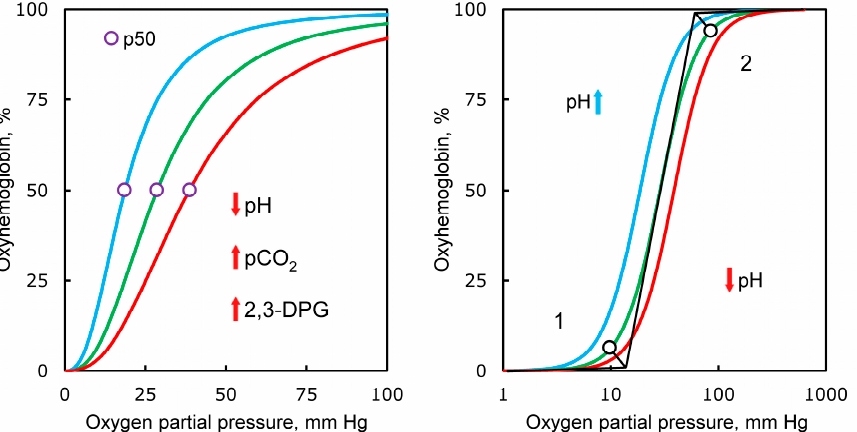
Figure 3. Different factors influencing oxygen saturation of hemoglobin. During pH change from 7.4 to 7.2, saturation decreases two times. The concentration of 2,3-diphosphoglycerate provides saturation of hemoglobin with oxygen, along with CO 2 pressure. pH, negative of the base 10 loga- rithm of the activity of the H + ion; pCO 2 , partial pressure of carbon dioxide gas; 2,3-DPG, 2,3-di- phosphoglycerate; p50, oxygen tension at 50% hemoglobin saturation.